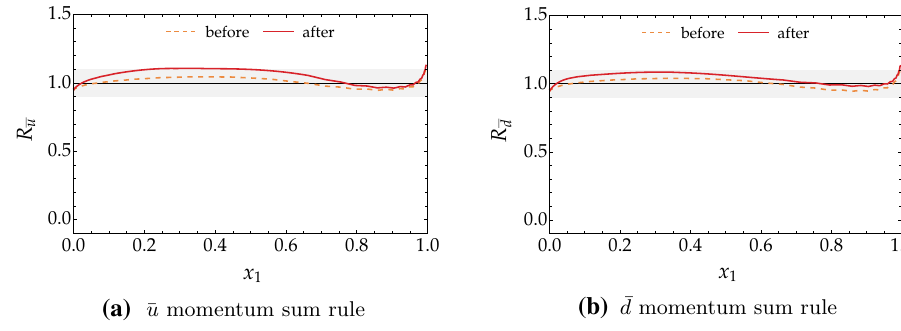
Fig. 11 Change of